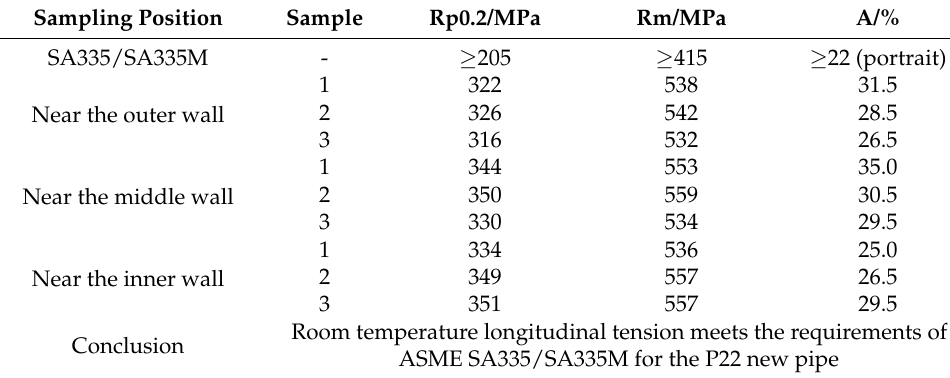
Figure 1. The size of the sample at room temperature (mm). Table 3. The results of the longitudinal tensile test.